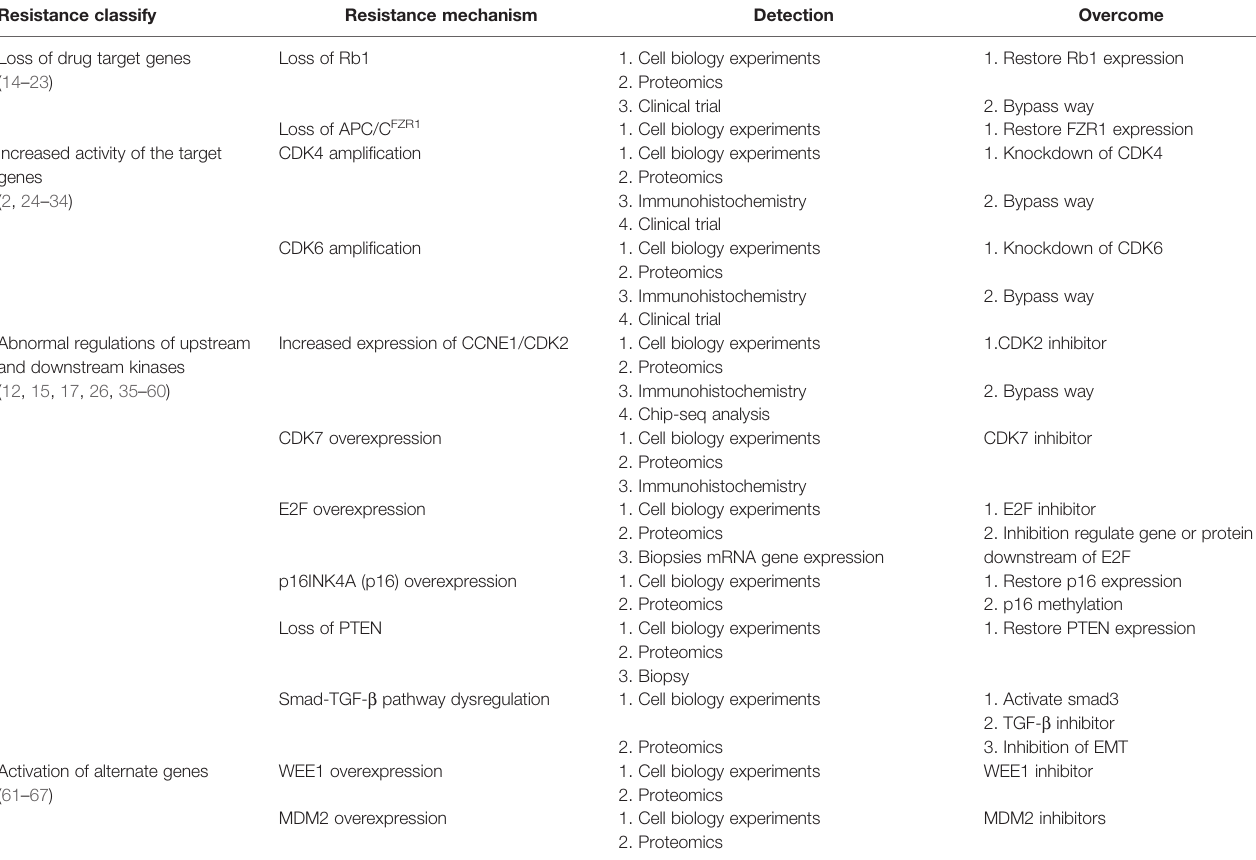
TABLE 1 | Mechanisms of acquired resistance to CDK4/6 inhibitors: Direct cell cycle mechanisms. Resistance